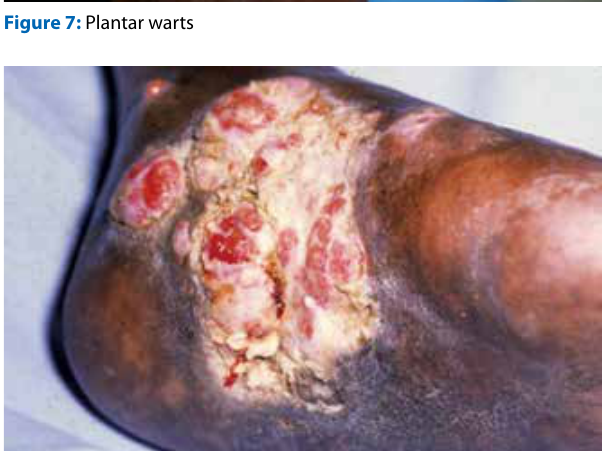
Figure 8: Eumycetoma of the left foot, with black granules being drained by the